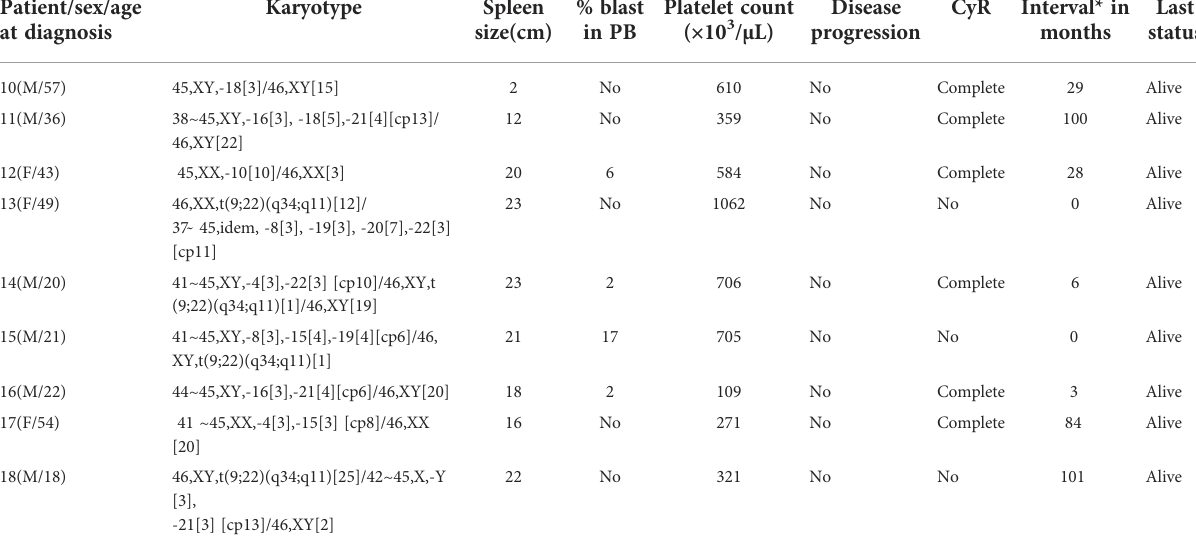
Karyotype Spleen